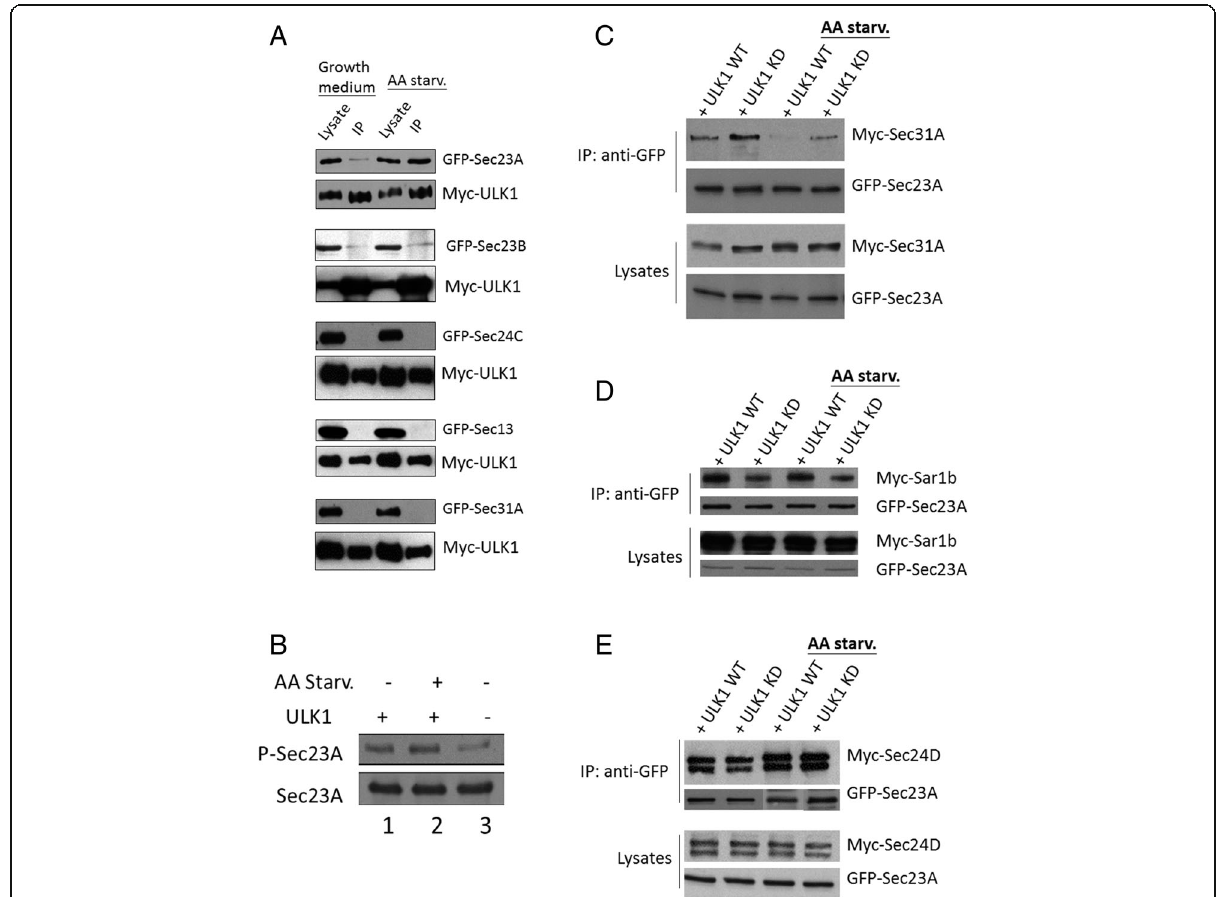
Fig. 4 ULK1 phosphorylates Sec23 and changes its binding to other COPII components. a Myc-ULK1 WT was co-transfected with indicated COPII components (GFP-tag) pairwise in HEK293T cell. ULK1 was immunoprecipitated by anti-Myc antibody and the presence of co-precipitated COPII components were detected by blotting with anti-GFP antibody. b Myc-ULK1 and Myc-Sec23A were separately overexpressed and purified from HEK293T cells by immune-isolation using anti-Myc antibody. Some of ULK1 transfected cells were put under amino acid starvation to further activate the ULK1 kinase activity. Beads loaded with ULK1 and Sec23A protein were mixed to allow ULK1 to phosphorylate Sec23A in vitro. Phosphorylated Sec23a was detected by Mouse anti-serine/threonine antibody. Total Sec23a was detected by Rabbit anti-Sec23a antibody. c-e HEK293T cells were transfected with the indicated plasmids and treated by EBSS or complete medium prior to harvest. AA star. Means amino acid starvation. After harvest, Sec23A was immunoprecipitated and detected by using monoclonal anti-GFP antibody. Sec31A ( c ), Sar1b ( d ) and Sec24D ( e ) were detected by mouse anti-Myc